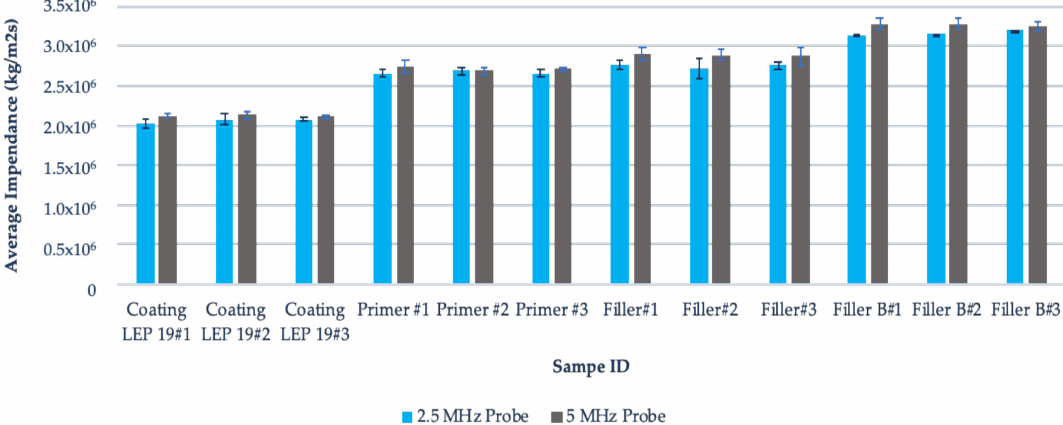
Figure 3. Average impedance measurements with the 2.5 and 5 MHz